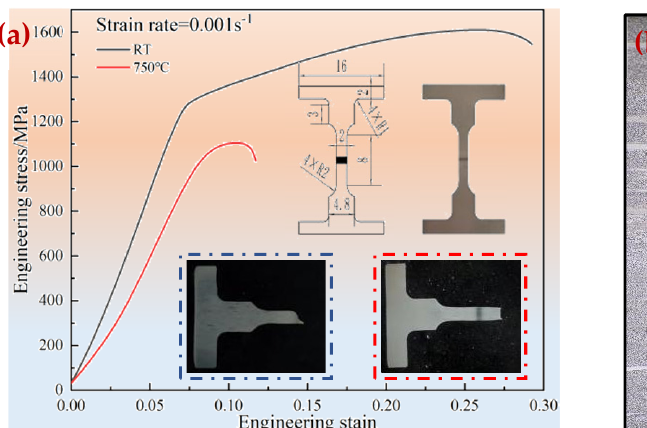
Figure 9. ( a , b ) Macro- and microfracture morphology of the tensile test temperature at RT, ( c , d ) Macro- and microfracture morphology of the tensile test temperature of 750 °C.